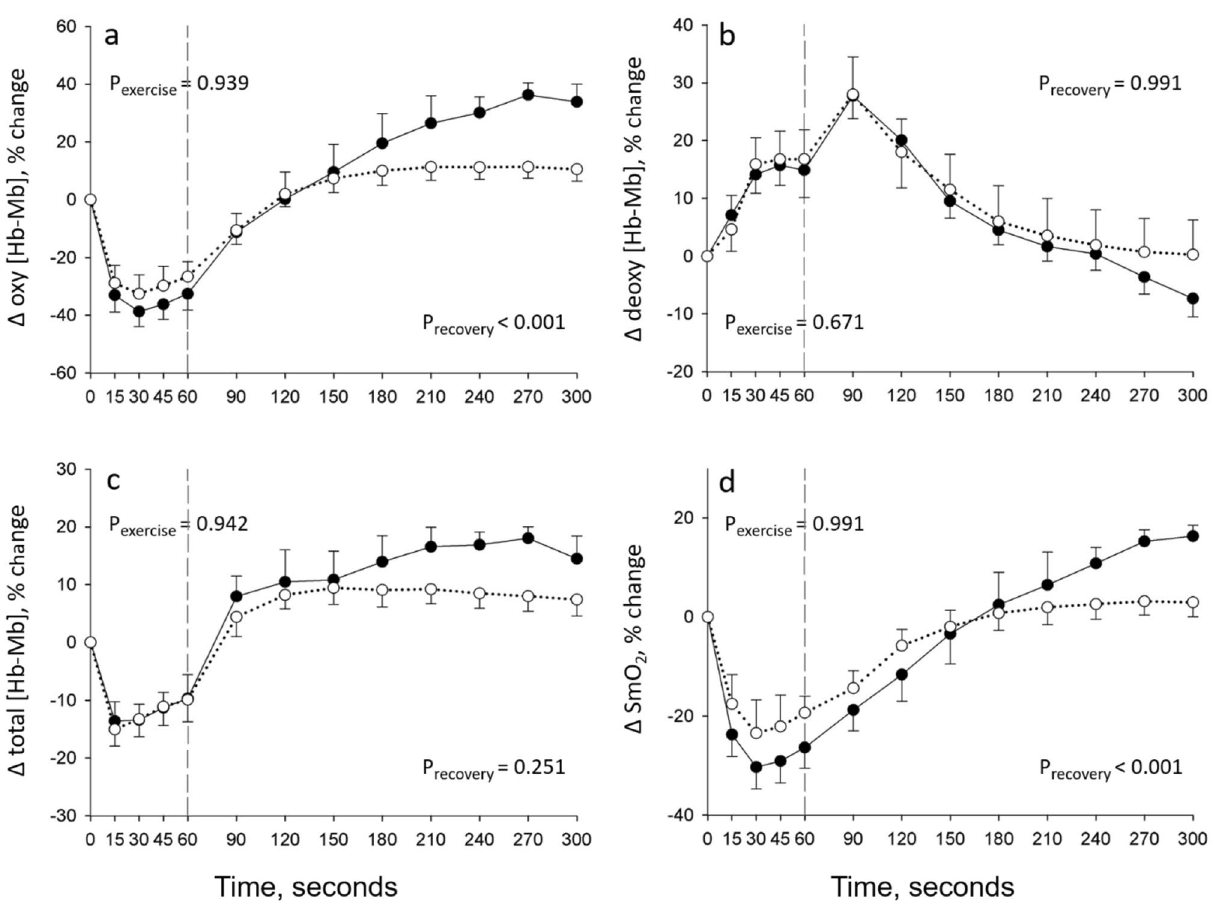
Figure 2. Time course of quadriceps ( a ) oxygenated (Δ oxy [Hb-Mb]), ( b ) deoxygenated (Δ deoxy [Hb-Mb]), ( c ) total (Δ total [Hb-Mb]) myoglobin–hemoglobin concentration, and ( d ) muscle saturation index (Δ SmO 2 ) during the 1STS and 4 min of recovery in people with COPD (full circles) and healthy subjects (open circles). Results are presented as mean ± SEM. Exercise and recovery data were analysed with two distinct two-way repeated measure ANOVAs, the p values report the interaction group × time during the 1STS and during the recovery periods,